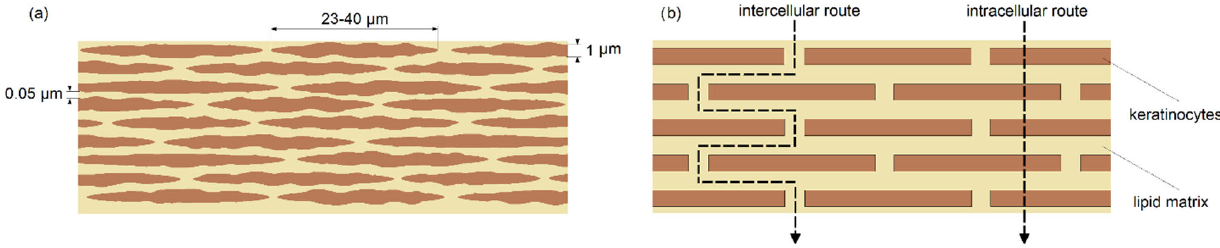
Figure 1. ( a ) structure of stratum corneum; ( b ) brick wall model.